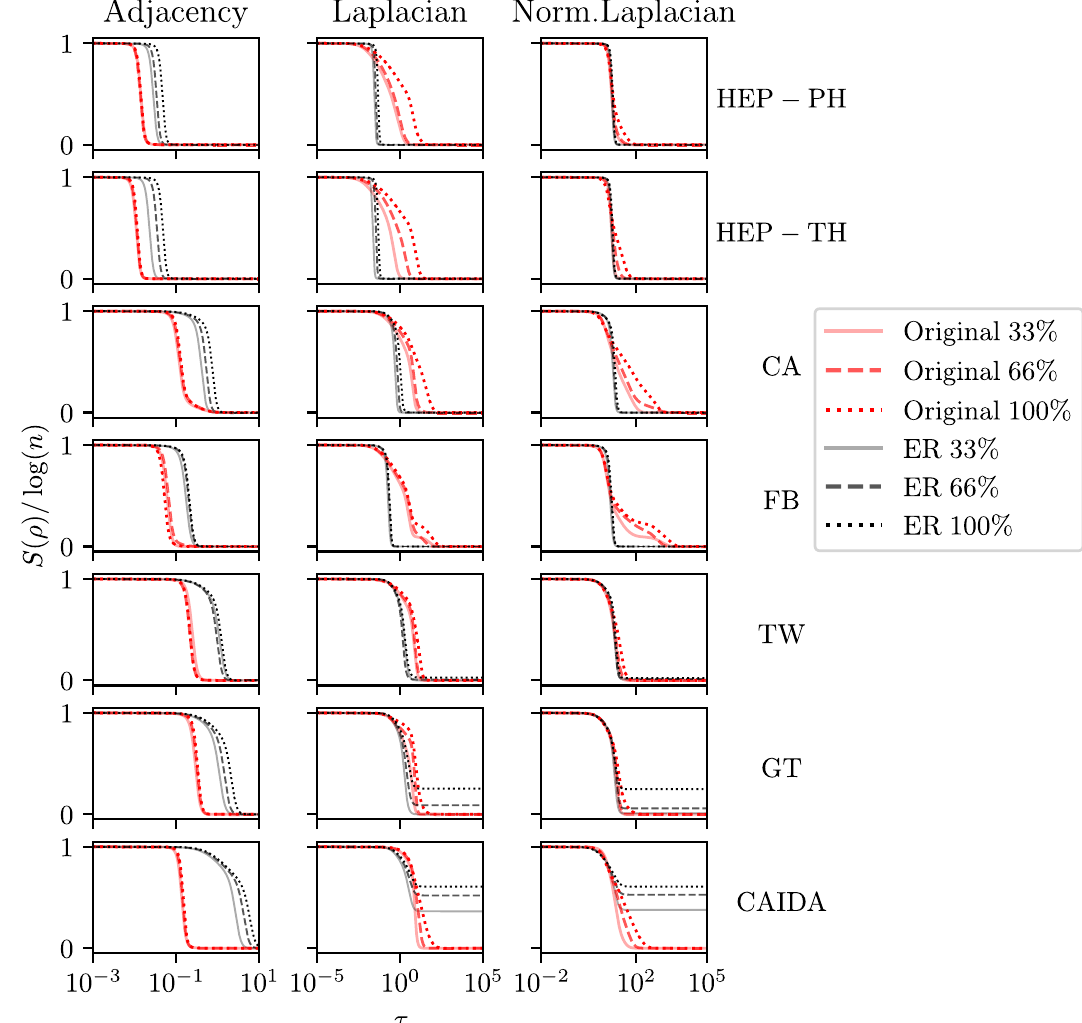
largest connected component. For each real-world graph, we generated ten Erdős–Rényi graphs with parameter p = 2 m / n 2 where n , m are the numbers of vertices and edges of the largest connected components of real-world graphs respectively. Finally, we took an average entropy. Subgraphs of real graphs were generated by choosing a vertex with the highest degree, and 33% and 66% vertices nearest to